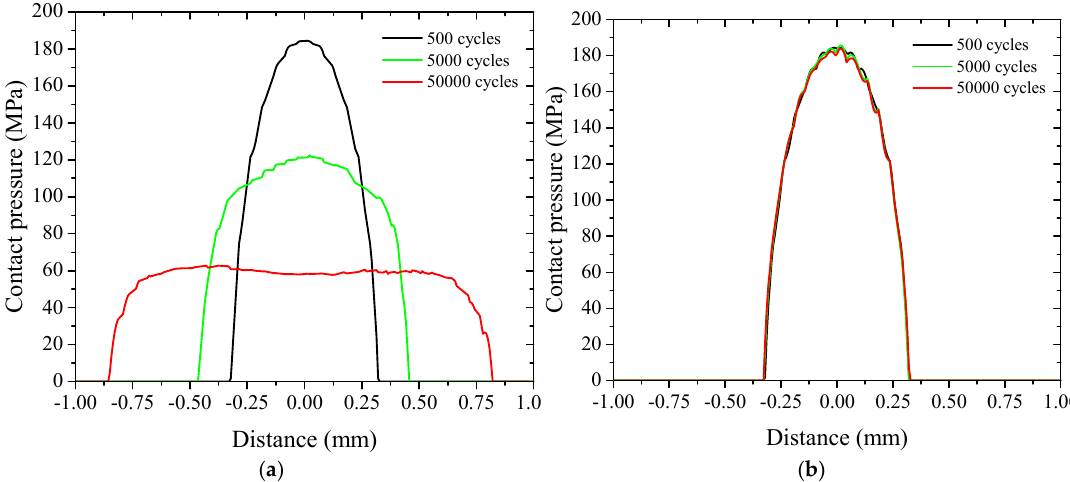
Figure 11. Evolution of temperature on the copper specimen with and without the consideration of fretting wear.